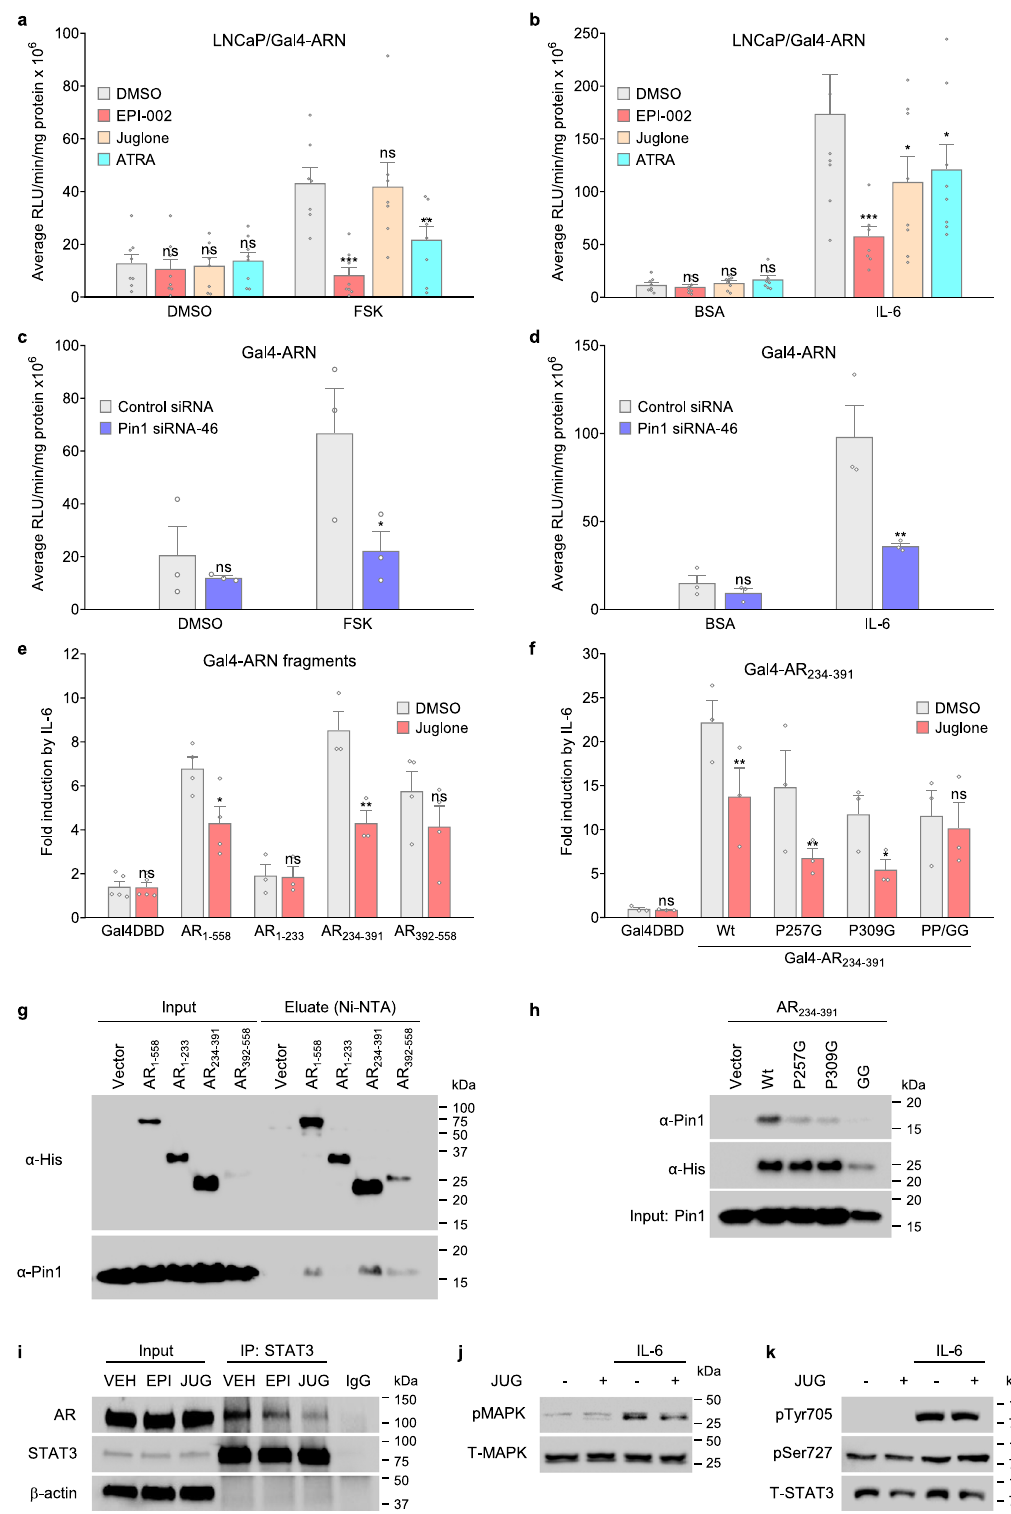
targets involved in mitosis 35